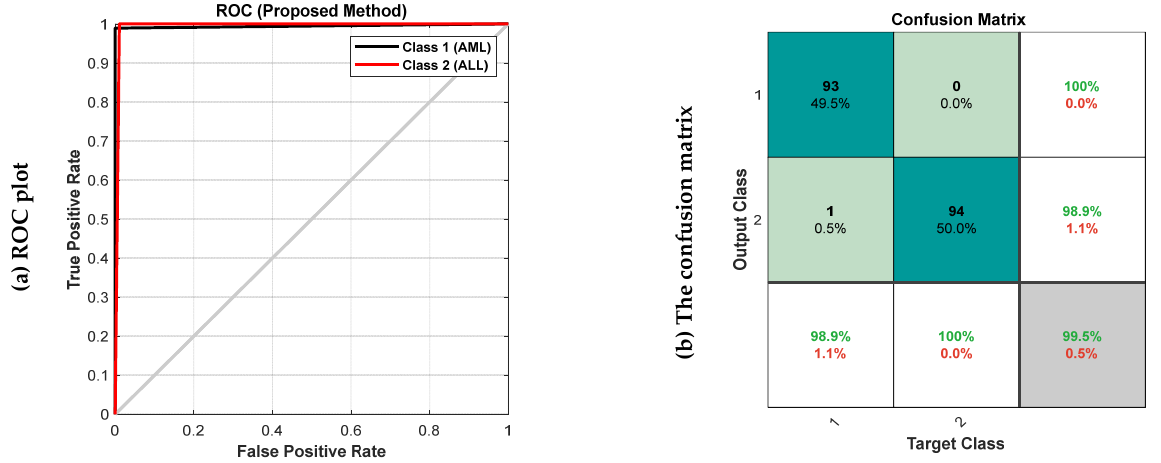
Figure 8. The ROC plot and confusion matrix based on the proposed customized CNN model for test data; ( a ) ROC plot, ( b ) The confusion